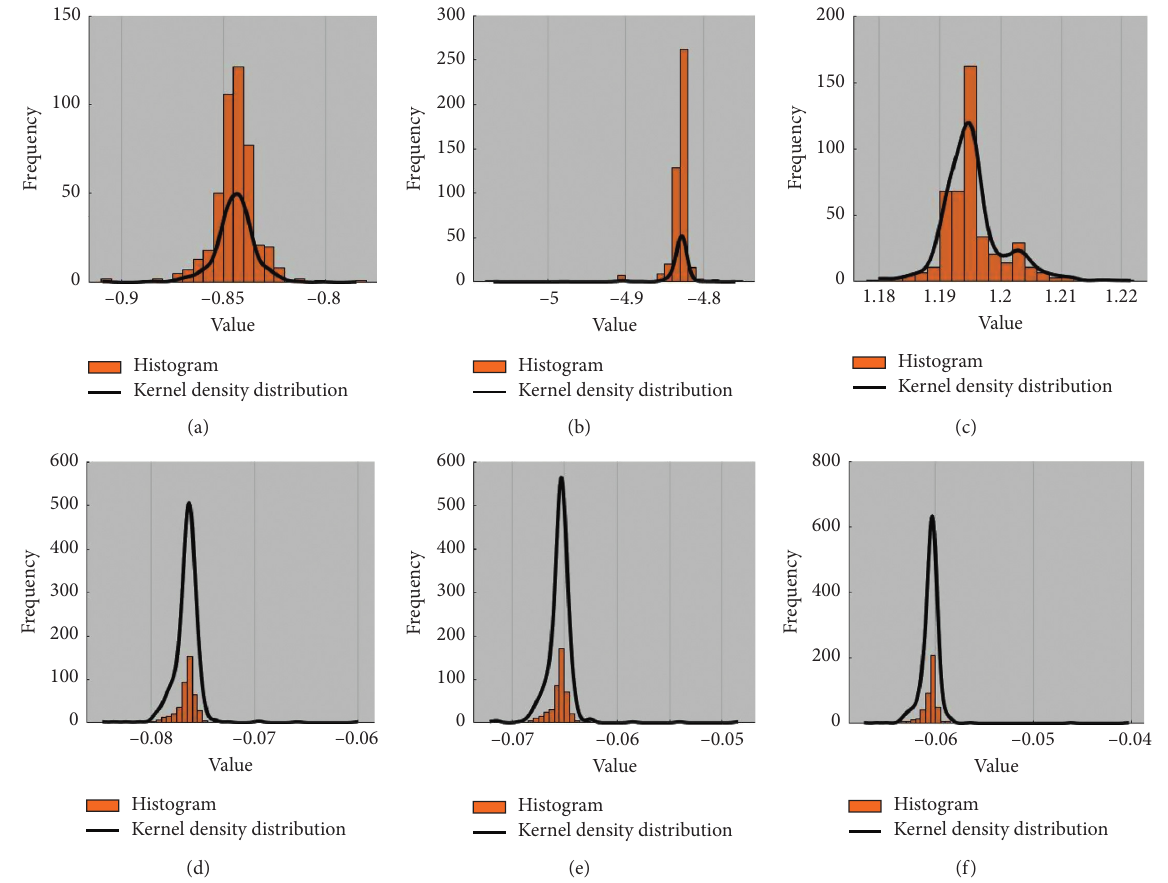
Figure 4: Empirical distributions of all the parameters: (a) λ